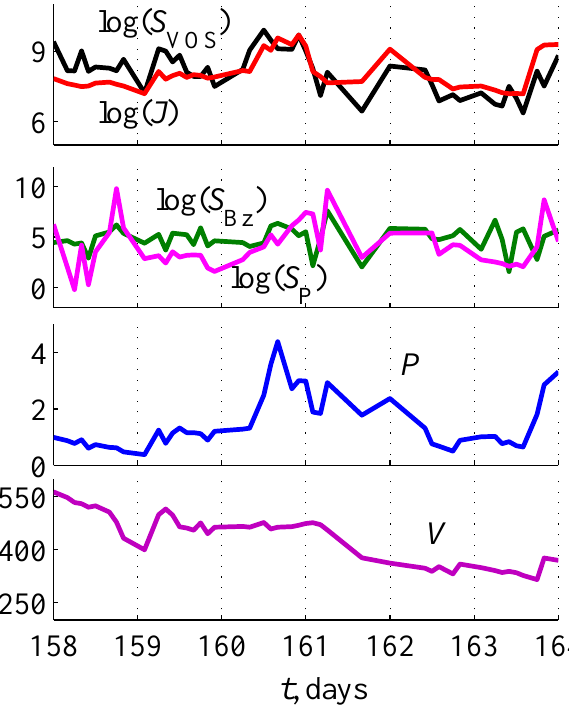
Fig. 10. Examples of variations of S VOS (black, upper) and J (red,upper), S P (green, second) and S Bz (magenta, second), P (third), and V (lower) for the interval 3 August 1998–8 August 1998.